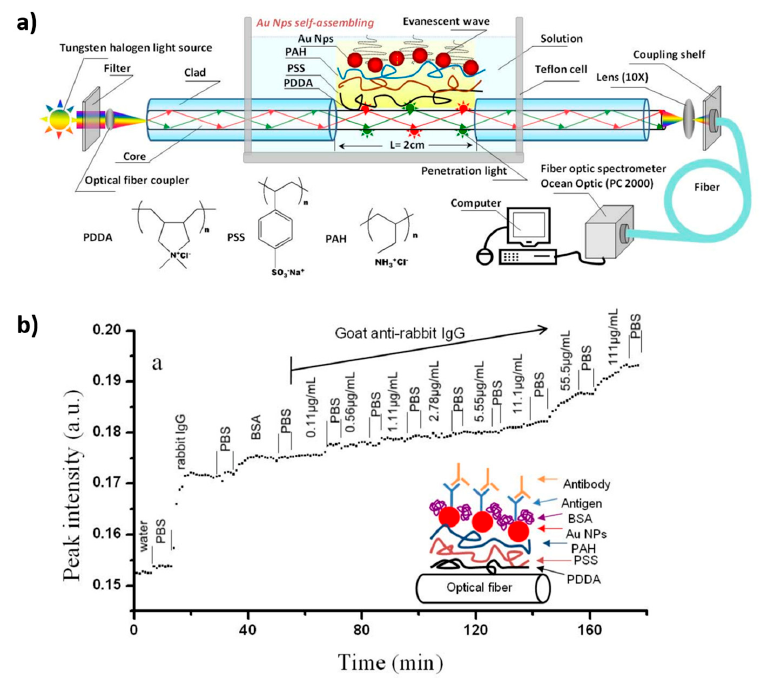
Figure 12. ( a ) Schematic representation of the experimental setup of the LSPR optical fiber sensor by using a trilayer polyelectrolyte structure which has been used to assemble the gold nanoparticles; ( b ) LSPR biosensing at different concentrations of goat anti-rabbit IgG from 0.11 to 100 µg/mL. Reprinted with permission from Ref. [74].